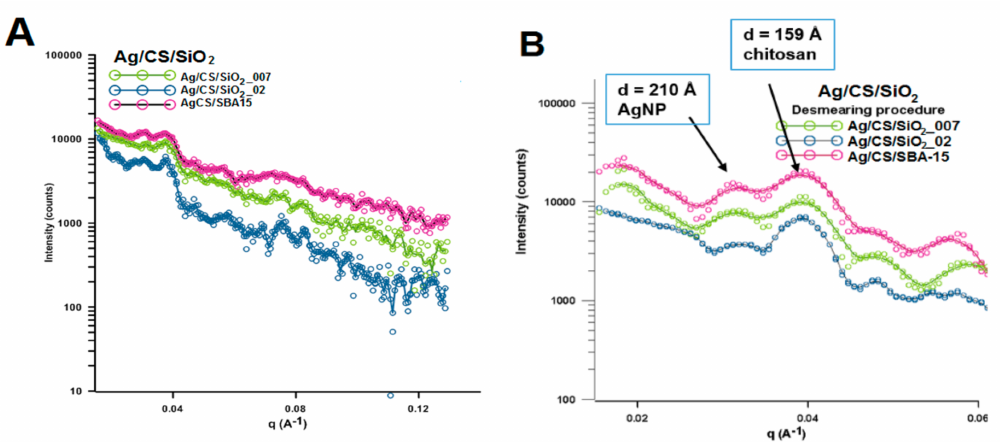
Figure 3. ( A ) Experimental small angle X-ray scattering (SAXS)profiles for Ag / CS / silica composites, ( B ) Experimental SAXS profiles for the investigated samples as line collimation data after desmearing. Note: The desmearing routines in Easy SAXS use a matrix inversion technique based on the Cholesky